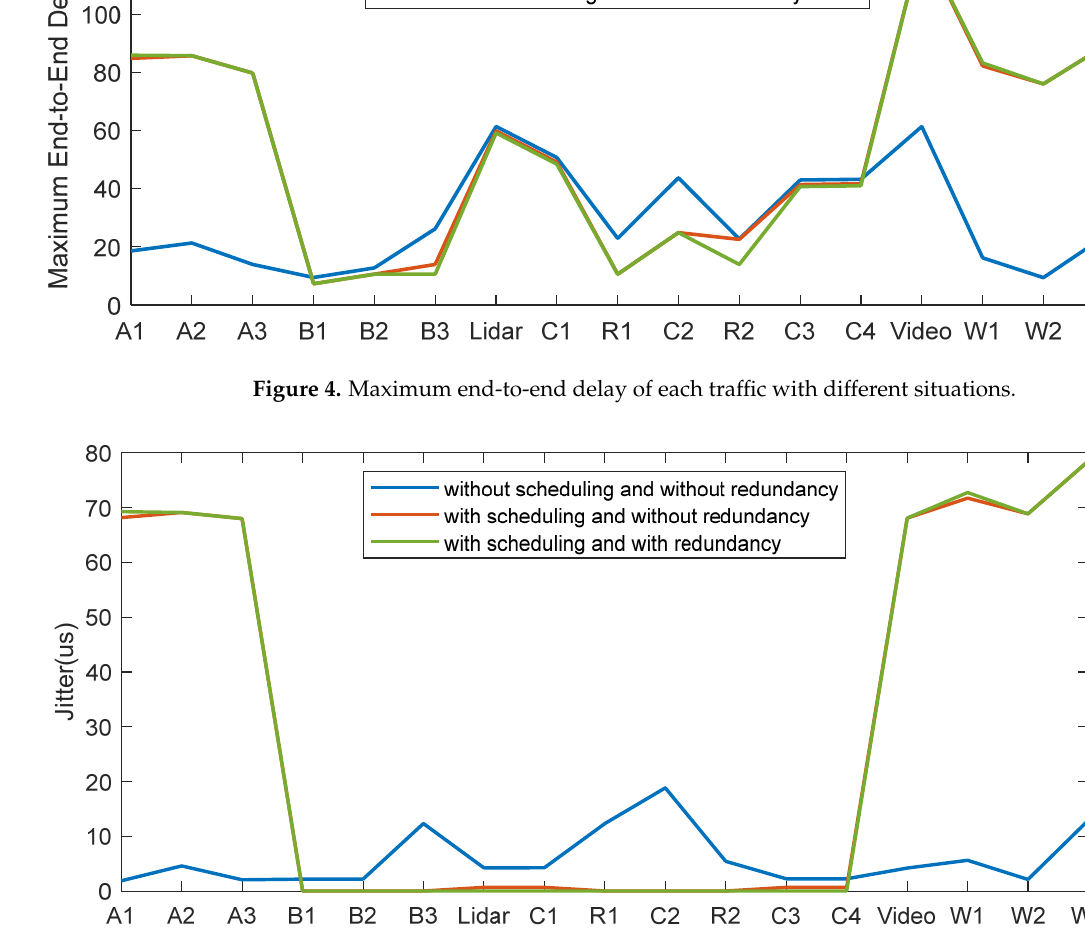
Figure 5. Jitter of each traffic with different situations.